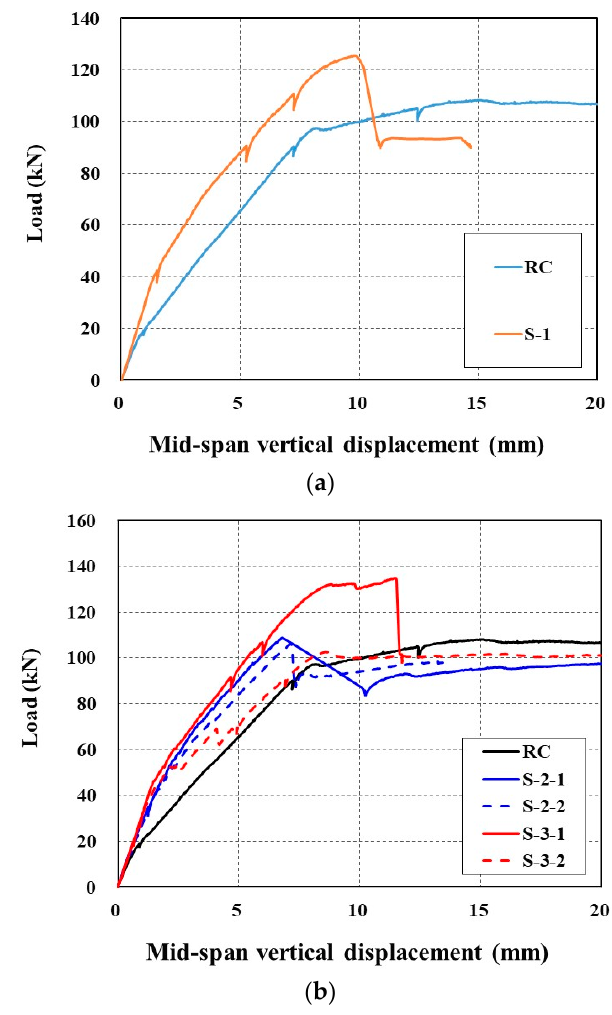
Figure 15. Comparison of load-displacement curves: ( a ) RC and S-1 specimens; and ( b ) RC, S-2, and S-3 specimens. S-3